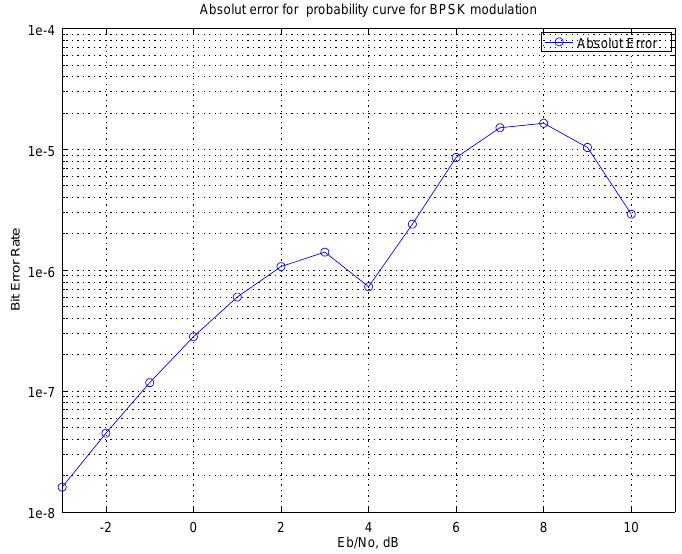
Figure 13: Bit error probability curve for PSK modulation in (43) .